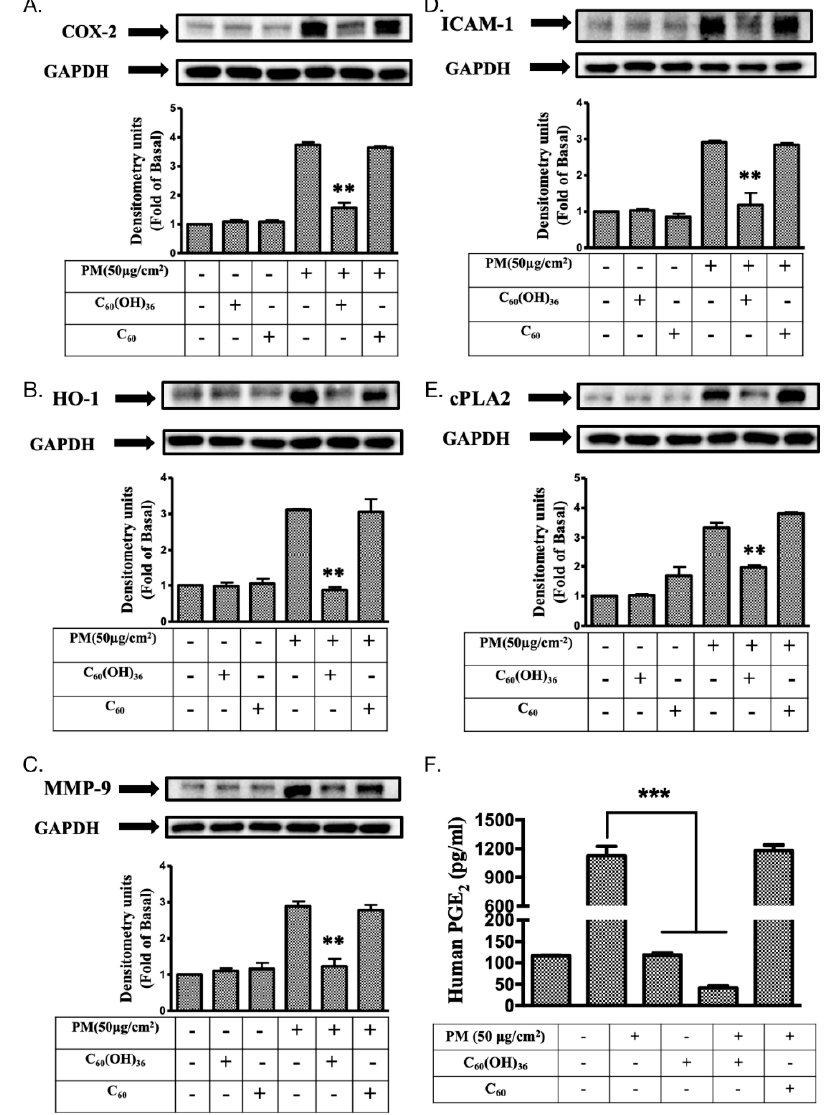
Figure 7. The changes in inflammation-related proteins in the fullerenol C 60 (OH) 36 and PM-treated HaCaT cells. The effects of inflammation-related proteins, including ( A ) cyclooxygenase-2 (COX-2), ( B ) intercellular adhesion molecular-1 (ICAM-1), ( C ) heme oxygenase-1 (HO-1), ( D ) cytosolic phospholipase A2 (cPLA2), and ( E ) metalloproteinase-9 (MMP-9) were measured by immunoblotting, and ( F ) prostaglandin E2 (PGE2) levels were detected using an ELISA kit in HaCaT cells that did or did not receive pre-treatment with 1 µ M fullerenol C 60 (OH) 36 or fullerene C 60 dissolved in water for 1 h, followed by PM (SRM 1649b, 50 µ g / cm 2 ) treatment for another 24 h. Glyceraldehyde 3-phosphate dehydrogenase (GAPDH) was used as a loading control during the immunoblotting process. Data were collected from at least three individual experiments and expressed as mean ± SEM values. * p < 0.01, as compared to the values for the PM exposure group.